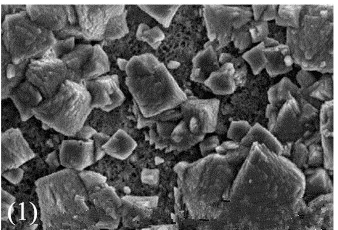
Figure 1. Mechanism of membrane wetting: ( 1 ) surface wetting, ( 2 ) partial wetting, ( 3 ) fully wetting.